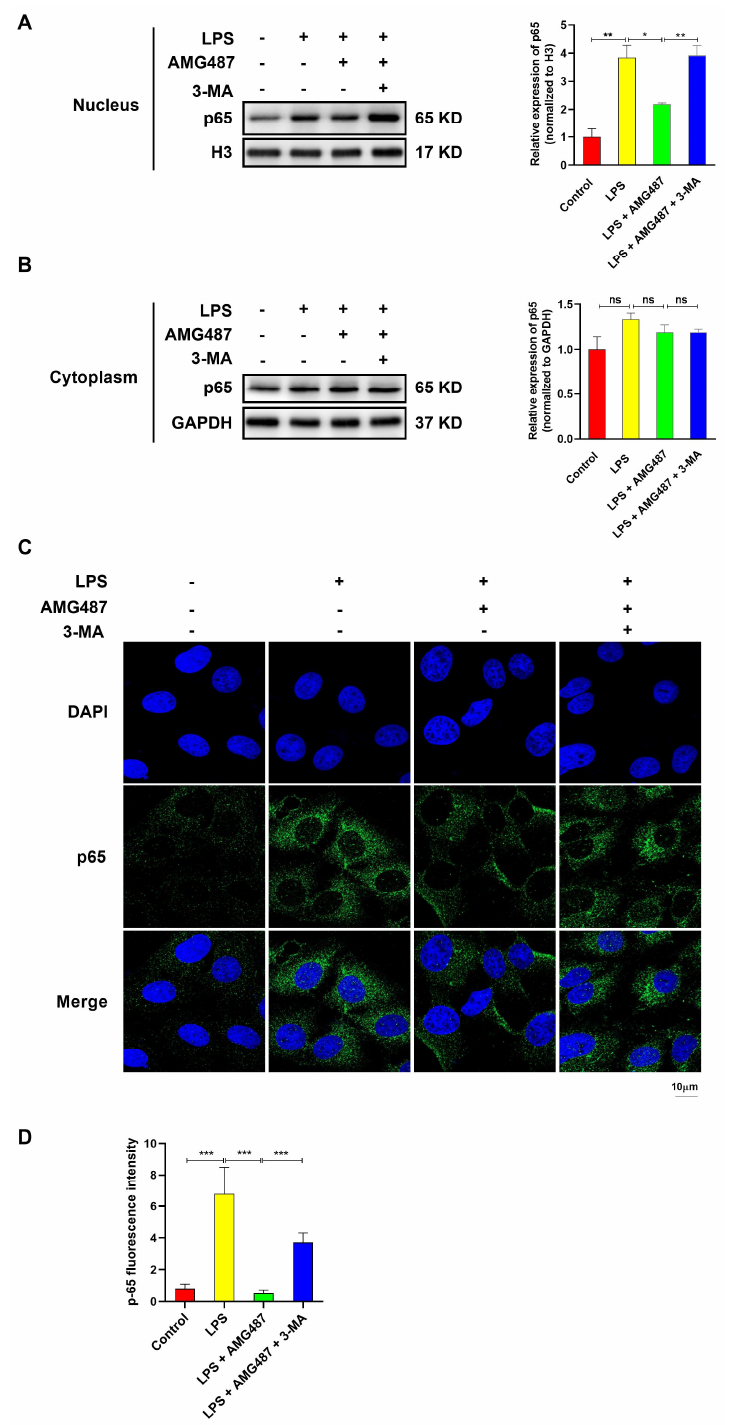
Figure 6. CXCR3 inhibition blocks p65 nuclear translocation by promoting autophagy in the IPEC-J2 cells. The cells were divided into four groups, namely, the Control group, LPS (10 µ g/mL) group, LPS + AMG487 (1 µ M) group, and LPS + AMG487 + 3-MA (5 mM) group. The cells were treated for 12 h. Nuclear and cytoplasmic proteins were extracted for Western Blot. An indirect immunofluorescence assay was explored. ( A ) The expression of p65 in the nucleus. ( B ) The expression of p65 in the nucleus cytoplasm. ( C ) Cell sub-localization of p65 with indirect immunofluorescence. ( D ) p-65 fluorescence intensity. The optical density values of p65 were detected by Image J software. Values represent the mean ± SEM. of three independent experiments. Significant differences are represented by * p < 0.05, ** p < 0.01, *** p < 0.01 and ns (not